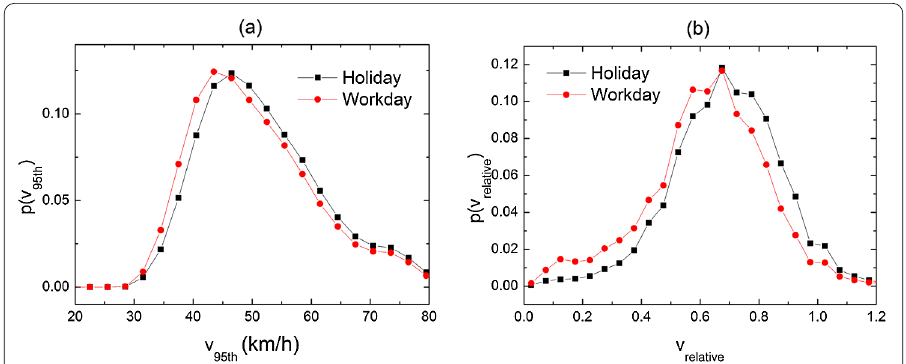
Figure 1 The distribution of the velocity. (a) The distribution of the 95th percentile velocity in workdays and holidays. (b) The distribution of the relative velocity during peak hour in workdays and holidays.